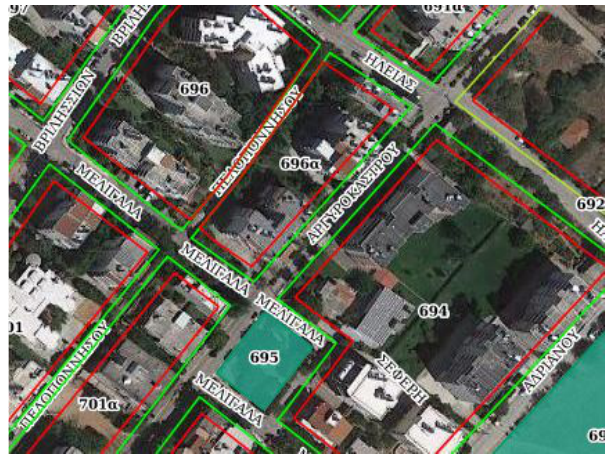
Figure 2. The two city blocks that consist the study area (696a and